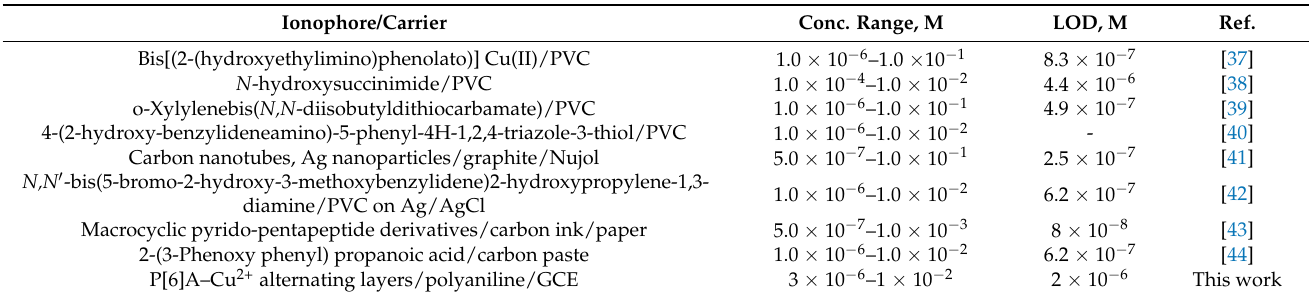
Table 3. Comparison of the performance of the solid-contact potentiometric sensors for Cu 2+ ions determination.